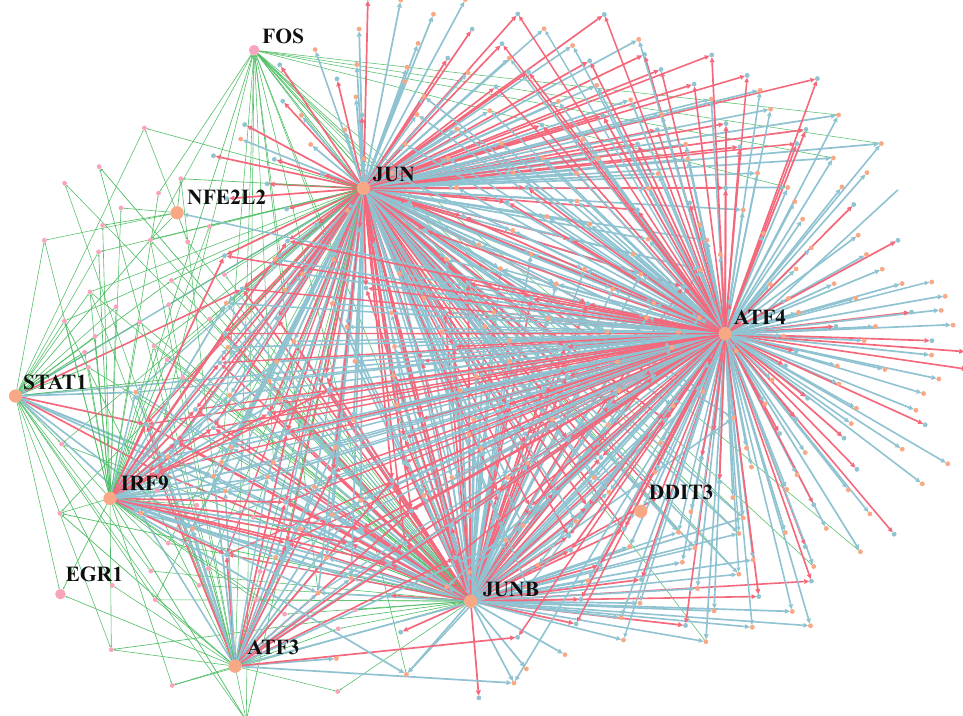
Figure 6. visualization of the GRN inference by MetaSEM on Cancer and Fibroblast datasets. The size of nodes indicates the regulatory weight. The blue edges are the main part of GRN, indicating the common regulatory relationship between the two cells. Green and red regulatory relationships only exist in Cancer GRNs or Fibroblast